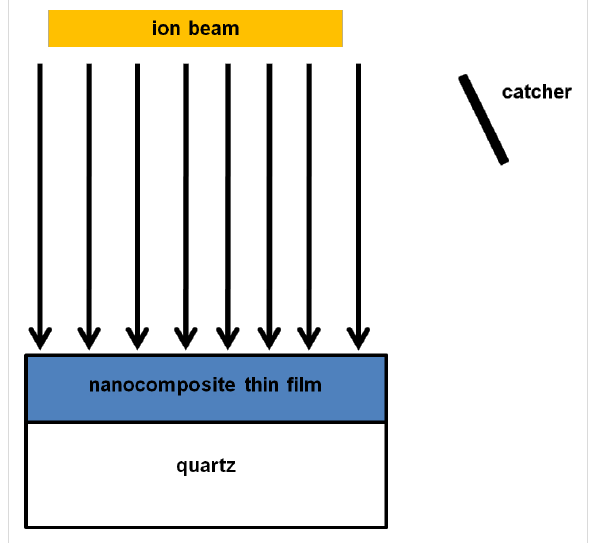
Figure 1: Experimental setup. The ion beam is incident perpendicu- larly to the nanocomposite thin film and catcher is placed at an angle of 60° from thin film